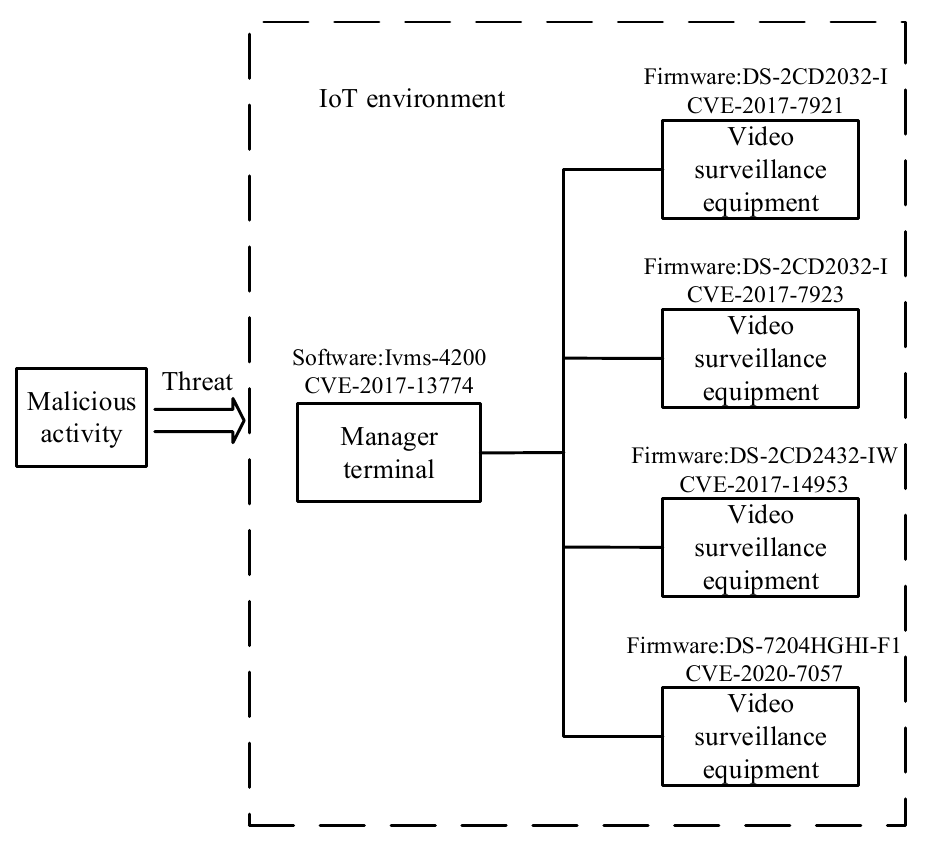
Figure 7. IoT context example.